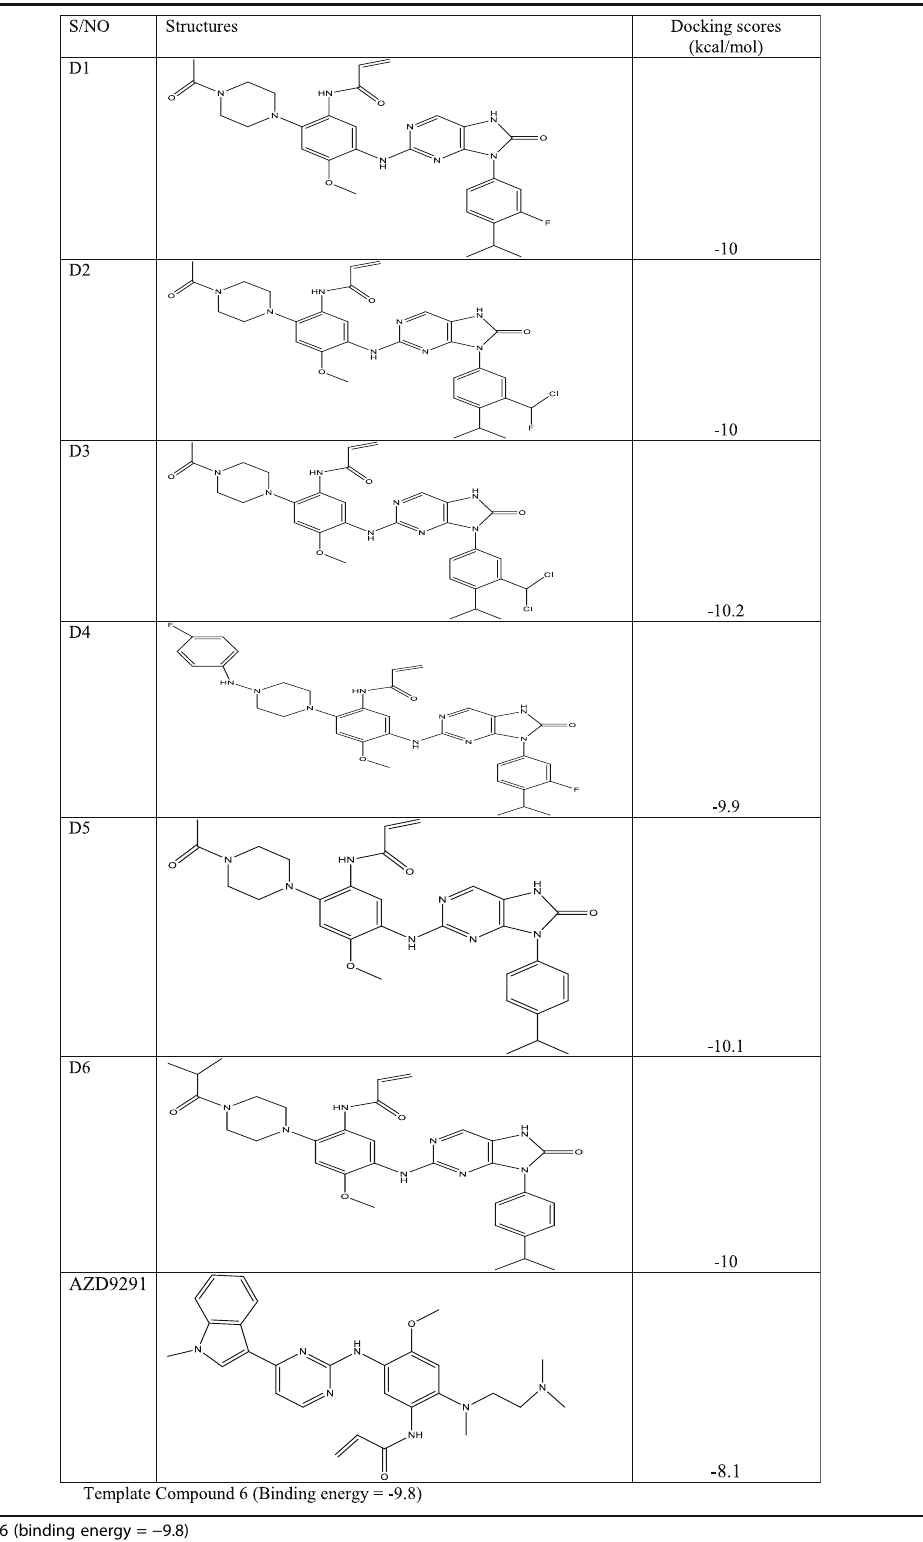
Table 5 The designed compounds with their binding